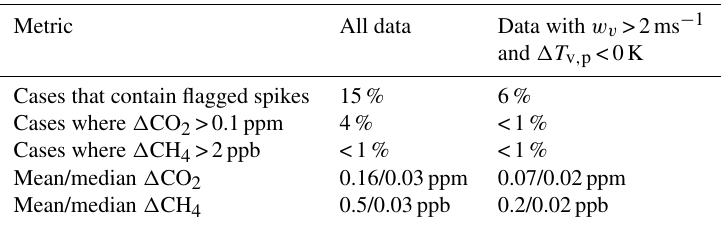
Table 3. Fraction of hourly averages of all data from the top inlet that contain flagged CO 2 spikes, and impact of removing them before averaging ( (cid:49) CO 2 , (cid:49) CH 4 ). Metric All